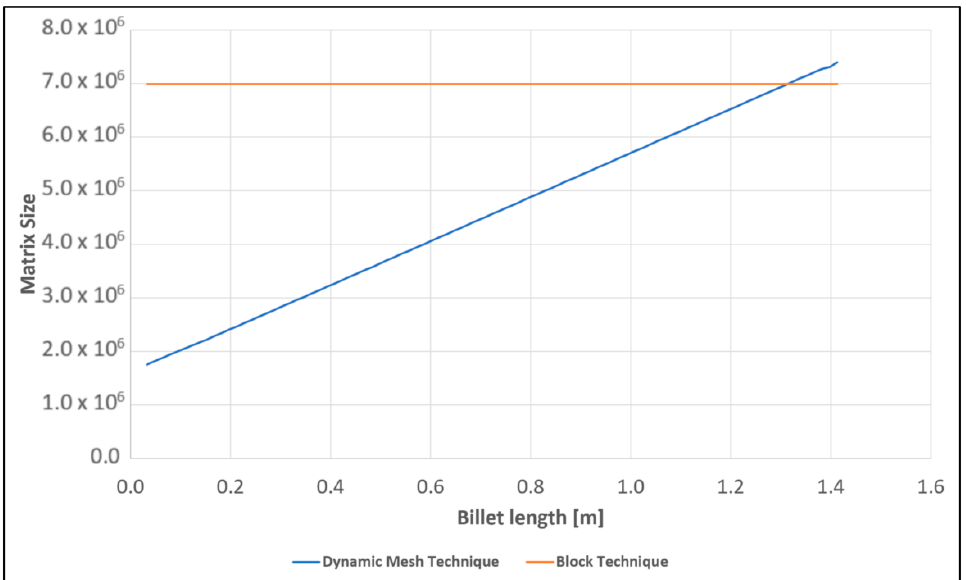
Figure 8. Comparison of matrix size during simulation over billet length between DMT and BT for 1.4 m billet length.